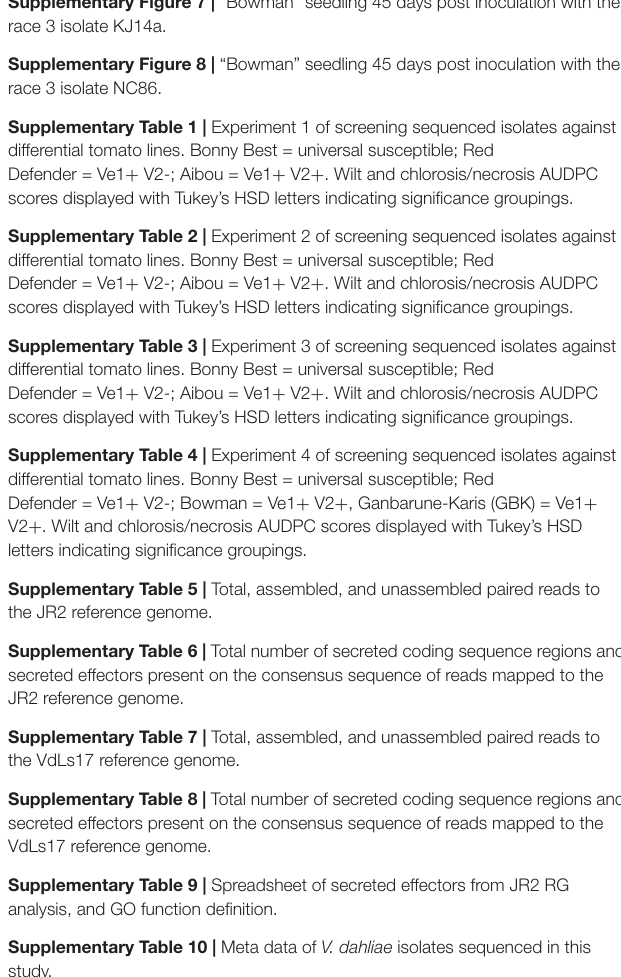
Supplementary Table 10 | Meta data of V. dahliae isolates sequenced in this